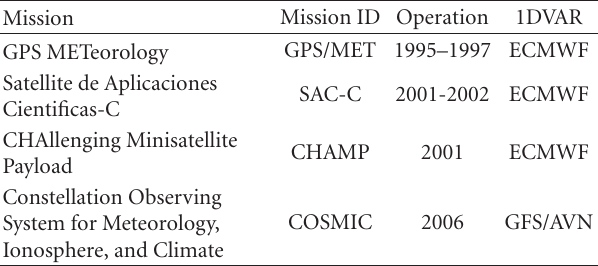
Table 1: GPS RO missions providing RO measurements through tropical cyclone regions defined via the respective years